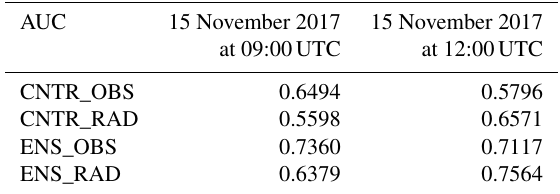
Table 1. Area under the ROC